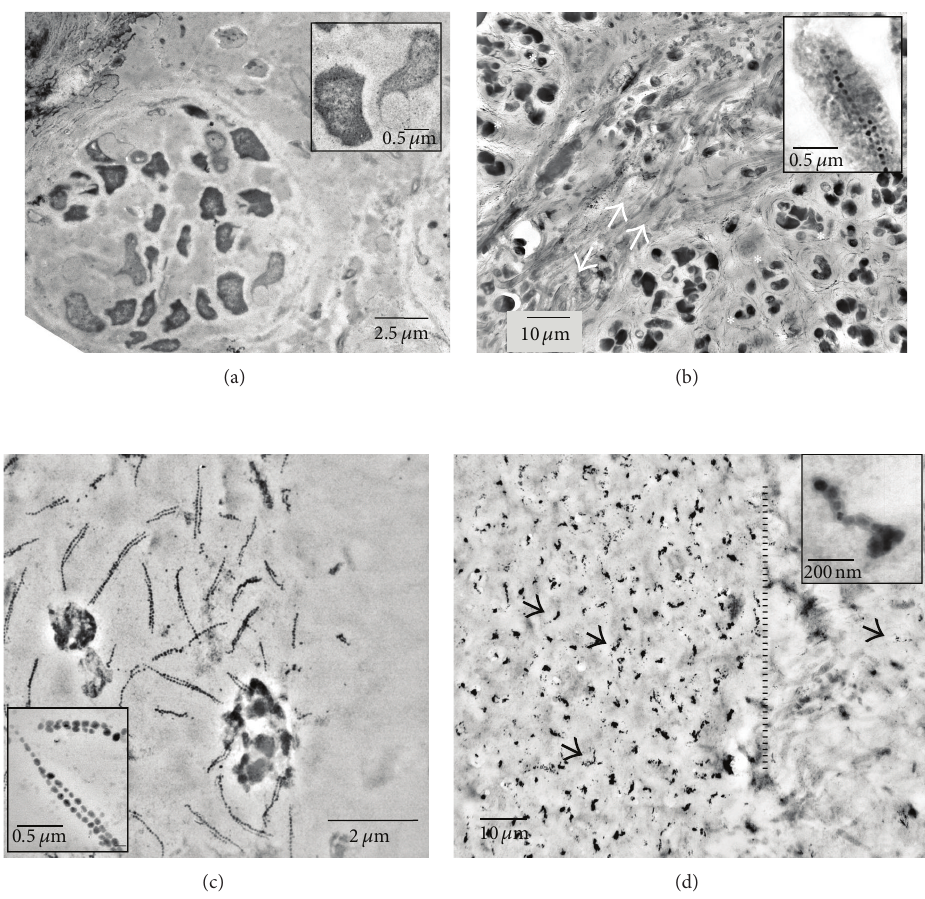
Figure 4: Aggregates in different stages of magnetosome-like chain formation. (a) ANME-2/SRB aggregate without visible precipitates. (b) Periphery of a large aggregate (asterisk), with gap between aggregates (arrows). Cells with multiple magnetosome-like chains (inset; see also (c)). Note cell debris, mainly consisting of envelopes from filamentous cells (arrows), outside the aggregates. (c) Periphery of an intact aggregate as depicted in (b) (unstained section; cells are invisible), showing the position of straight magnetosome chains inside cells. (d) ANME-2/SRB aggregate after cell lysis (cells are absent in spite of staining, compare (c)), with magnetosome chains still in place (some chains are marked by arrows). The inset shows a single chain. The dotted line marks the border of the aggregate (right of the dotted line). Some chains are found outside the area of the